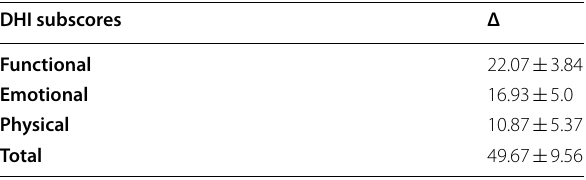
Table 2 Value of change (Δ) of the DHI subscores after vestibular rehabilitation as compared to the pre-vestibular rehabilitation